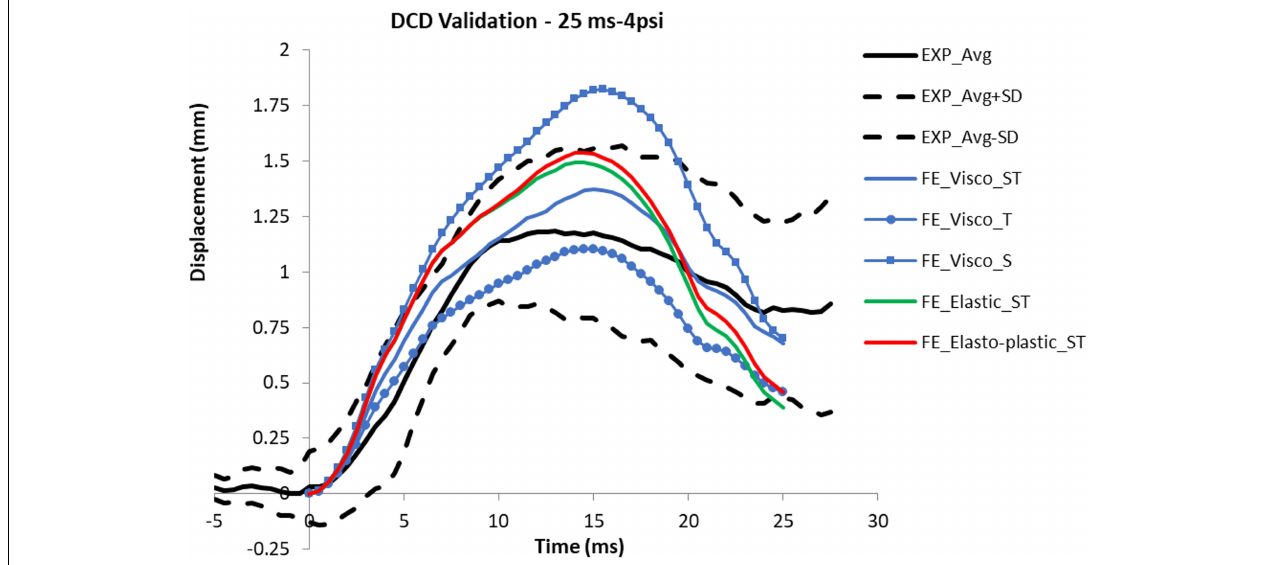
FIGURE 6 | Comparison of the displacement curves predicted from the models defined with various material models and interface types with the experimental corridor (average and average ± sd).